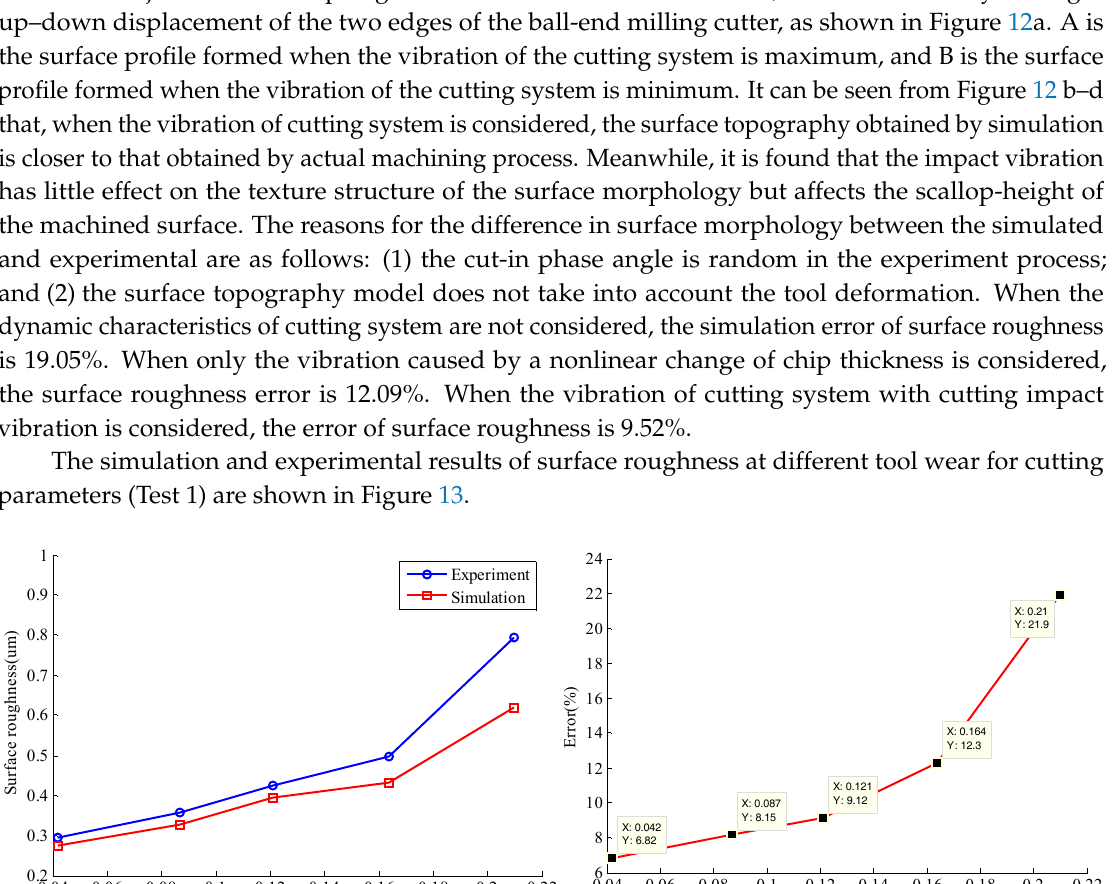
Figure 13. Simulation and experiment of surface roughness at different tool wear. VB—the tool wear. ( a ) effect of tool wear on surface roughness; ( b ) error.